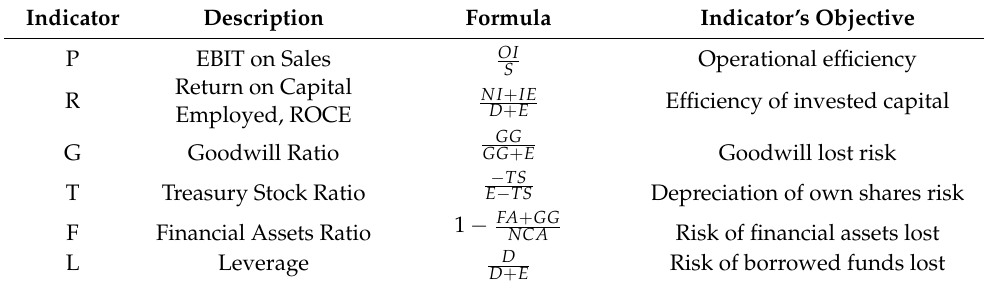
Table 1. The financial indicators